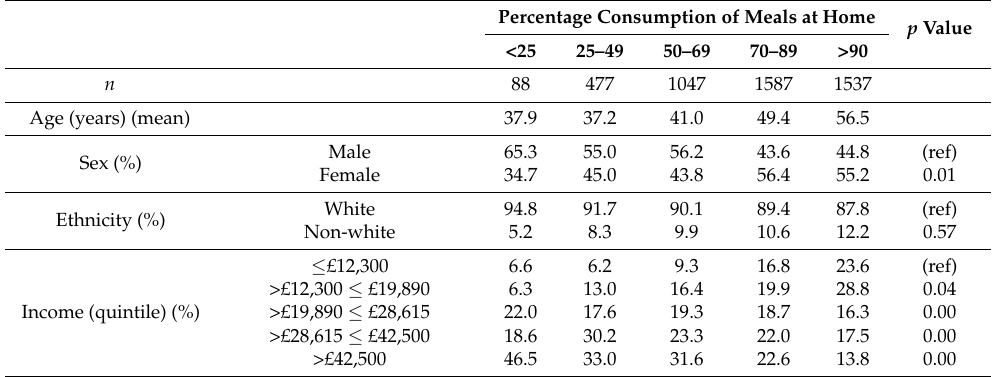
Table 3. Characteristics of the NDNS RP Years 1–4 (2008–2012) adult population by consumption pattern of meals at